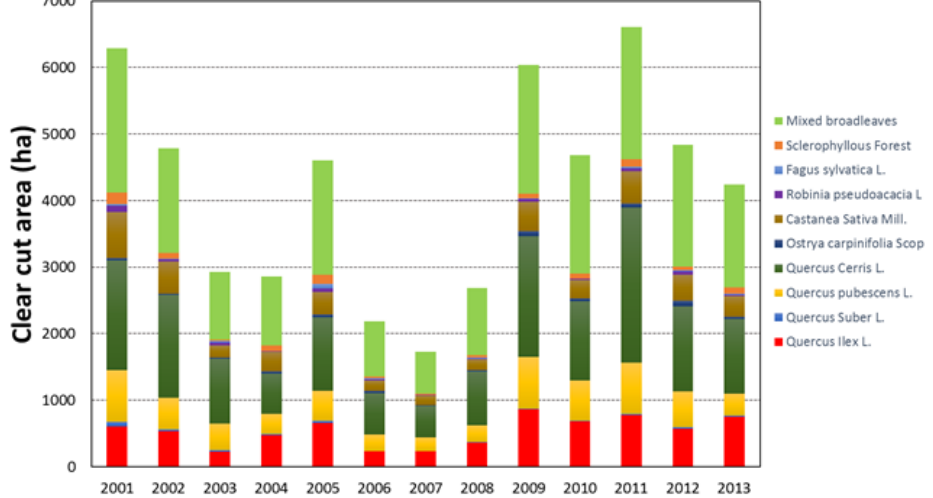
Figure 8. Forest area logged by year and for the main Tuscany forest types in the portion of Landsat scene 192 030 within the borders of Tuscany Region.